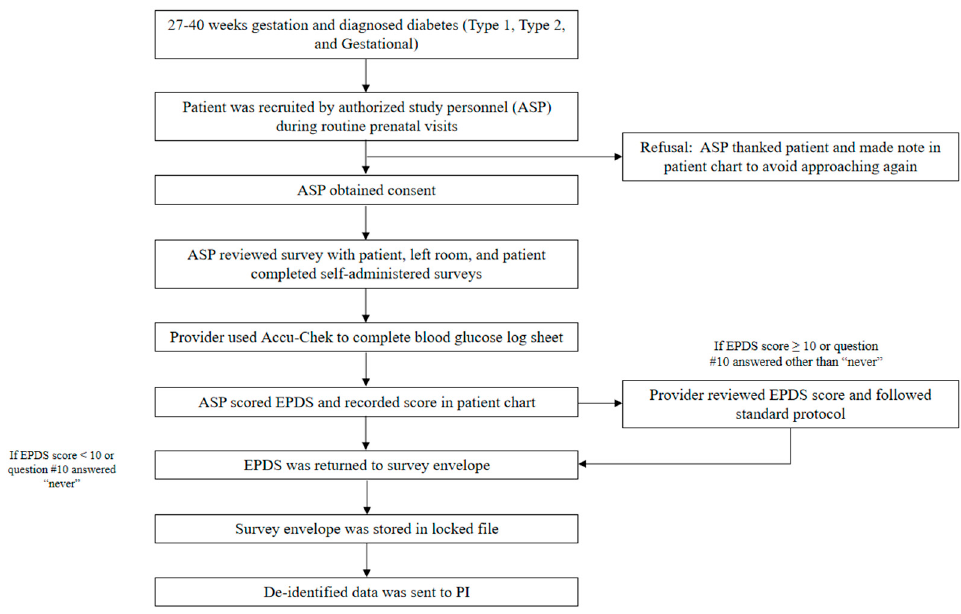
Figure 2. Participant recruitment